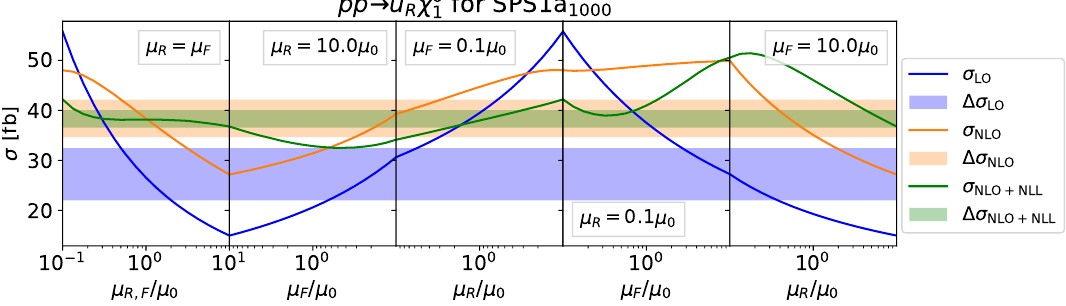
Figure 3. Profile of the renormalisation and factorisation scale dependence of the total cross section for the process pp → ˜ u R ˜ χ 0 . The plot covers µ F,R ∈ (0 . 1 − 10) µ 0 (reversely in panels 2 and 3), where 1 the central scale is µ 0 = ( m ˜ q + m ˜ χ ) / 2 . The bands show the scale uncertainties as obtained from the seven-point method. The predictions in this plot are for a centre-of-mass energy of CTEQ6.6M